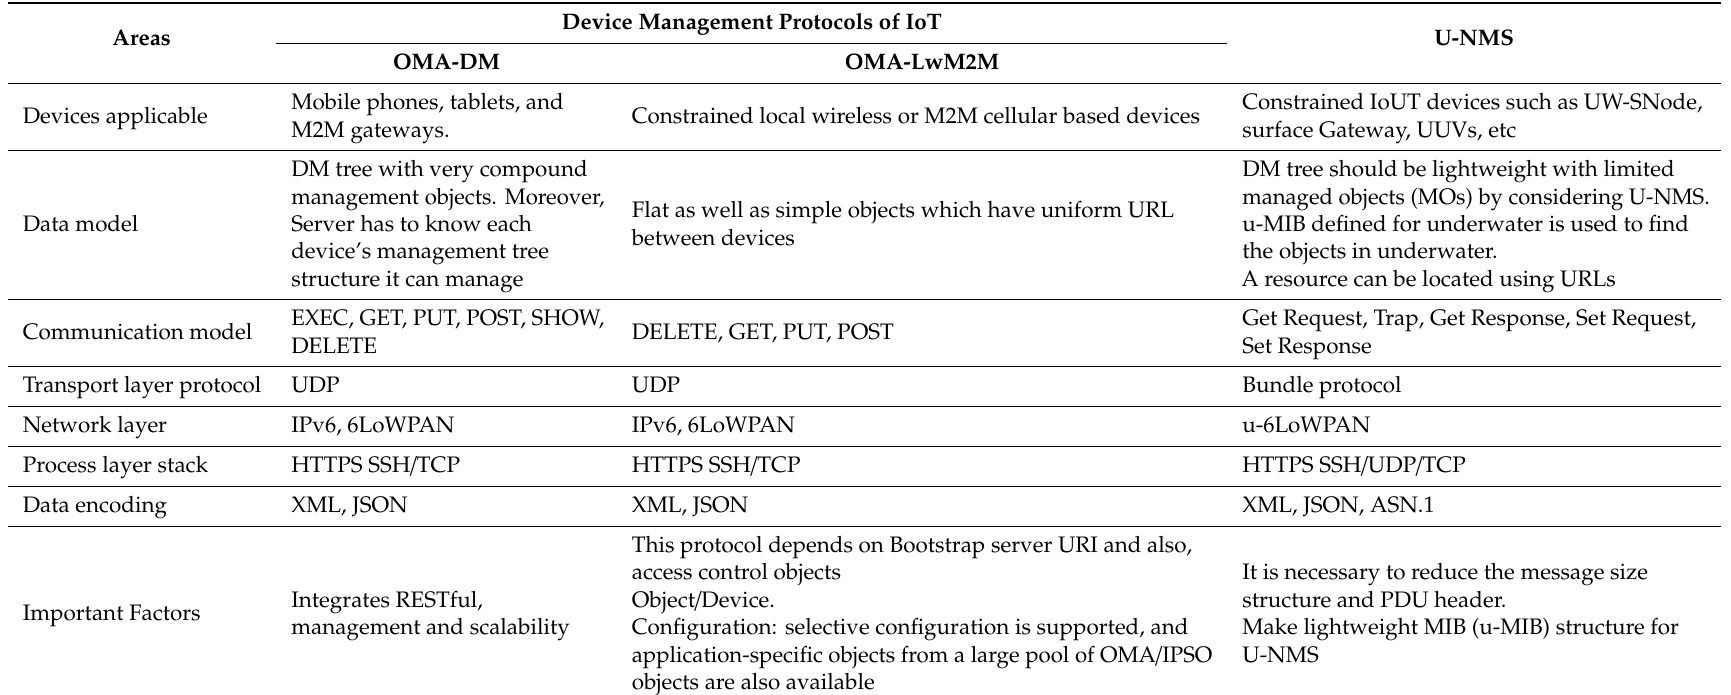
Table 5. Device management protocol comparison with U-NMS